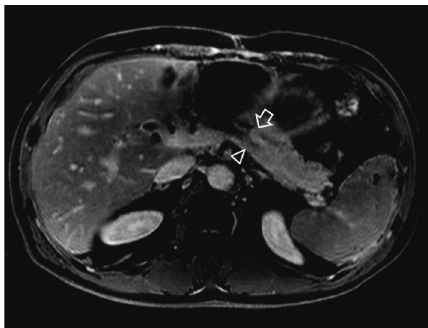
Figure 3: Postoperative followup dynamic magnetic resonance T1- weighted imaging of the remnant pancreas depicting the main as well as the secondary pancreatic duct (arrow and arrowhead resp.) draining the remaining dorsal pancreas at the level of the double pancreaticojejunal